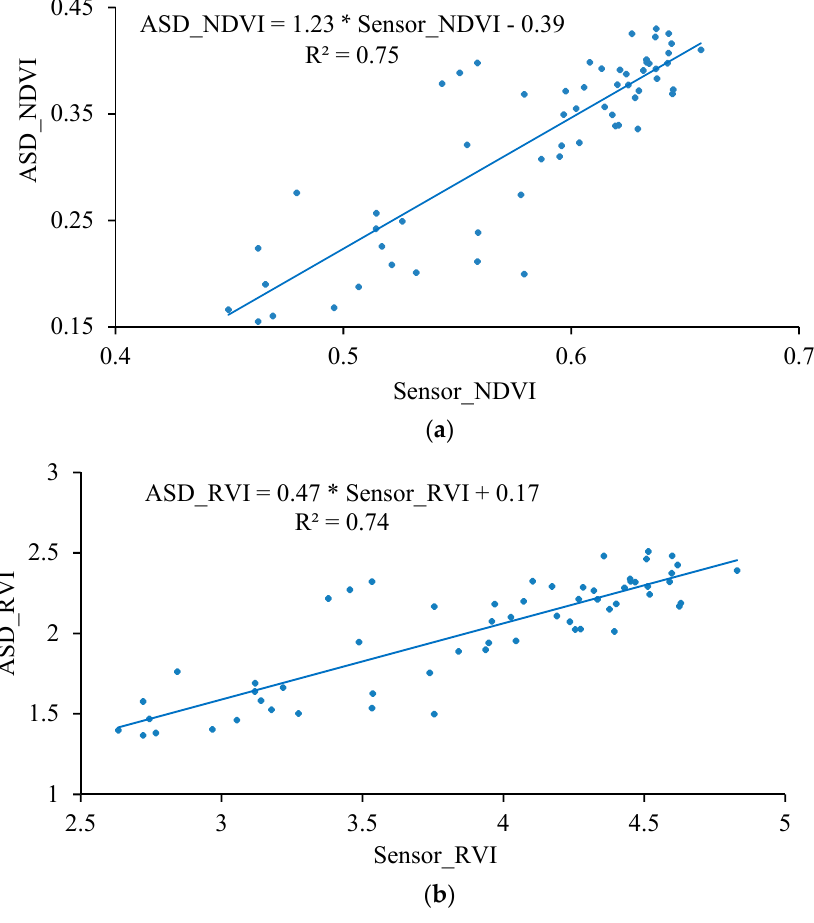
Figure 16. Fitting curves for the UAV-borne sensor and ASD data. ( a ) NDVI; ( b ) RVI.